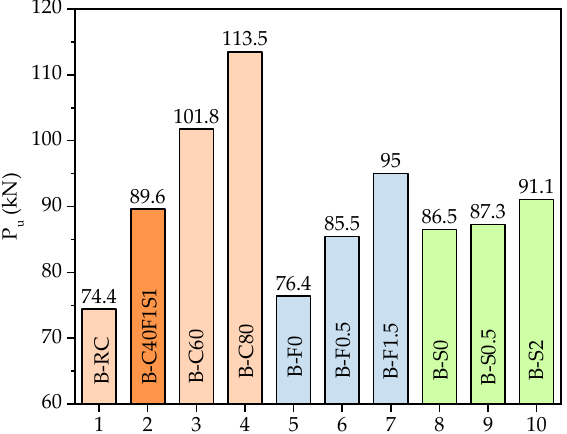
Figure 5. Ultimate load of all tested specimens. In comparison with the B–F0 specimen, the ultimate load ( P u ) of B–F0.5, B–C40F1S1, and B–F1.5 specimens with 0.5%, 1.0%, and 1.5% steel fiber volume fractions were improved by 12%, 17%, and 24%, respectively. Greater improvement is generally obtained with a volume fraction of beams can be an effective means of improving the ultimate